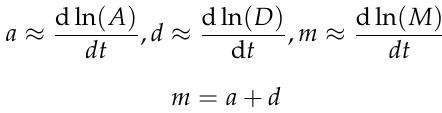
Figure 2. Relationships between observed and predicted vegetation carbon densities for different forest types.